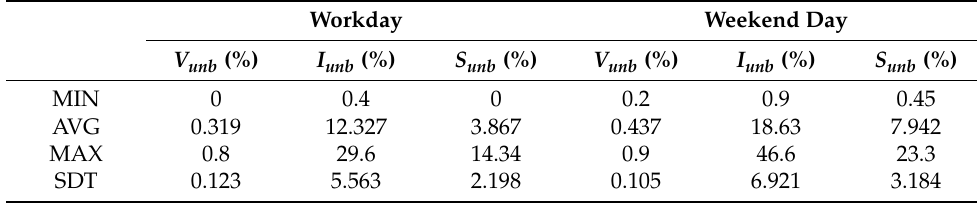
Table 5. The main values of V unb , I unb , and S unb .